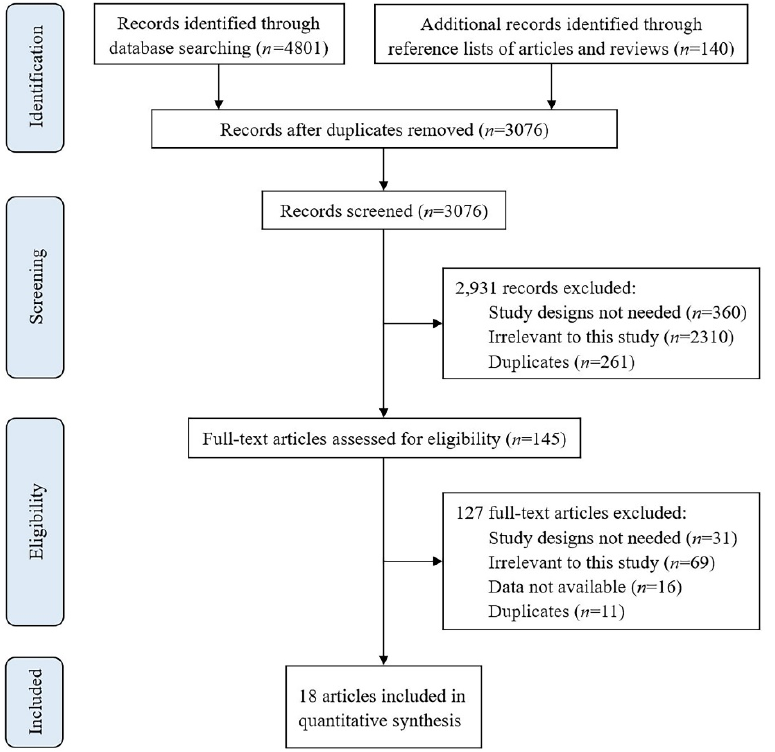
Figure 1. Flowchart of the study selection.